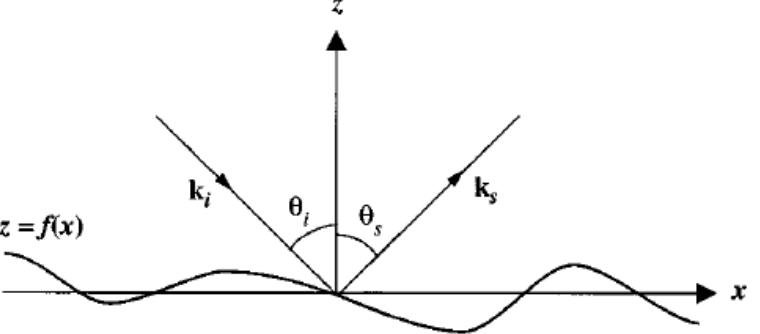
Figure 8. Figure 1. Thorsos’ Figure 1 [112]. Scattering geometry. Reproduced with permission Figure 1 . Thorsos’ Figure 1 [112]. Scattering geometry. Reproduced with permission from [112], AIP from [112], AIP Publishing, Publishing, 1997.